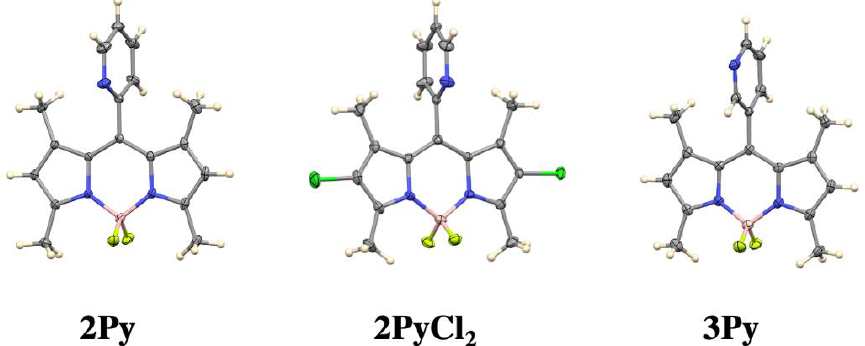
Figure 4. Crystal structures of 2Py , 2PyCl 2 and 3Py BODIPYs with 50%